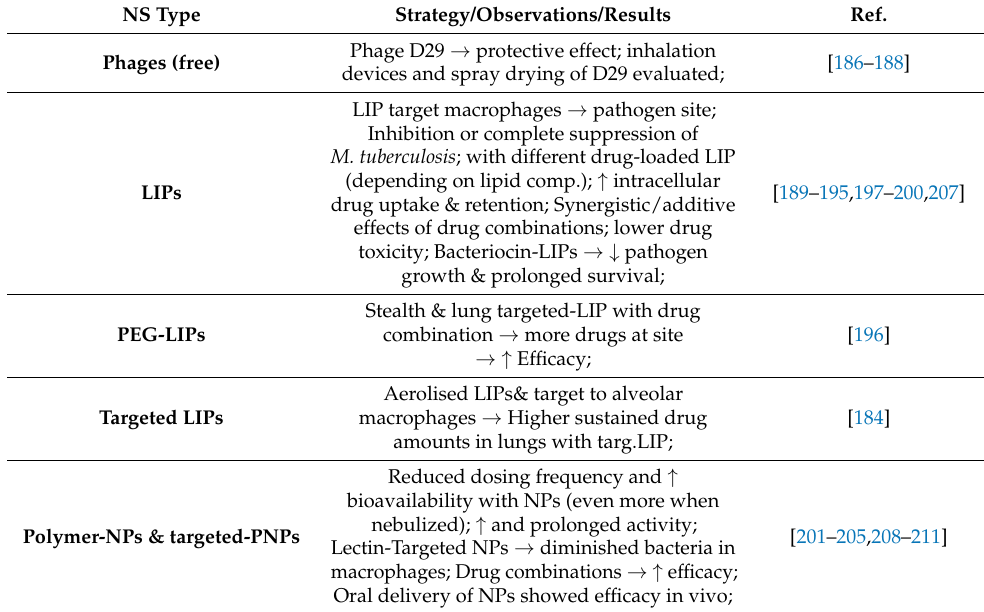
Table 9. Nanosystems for treatment of MTB